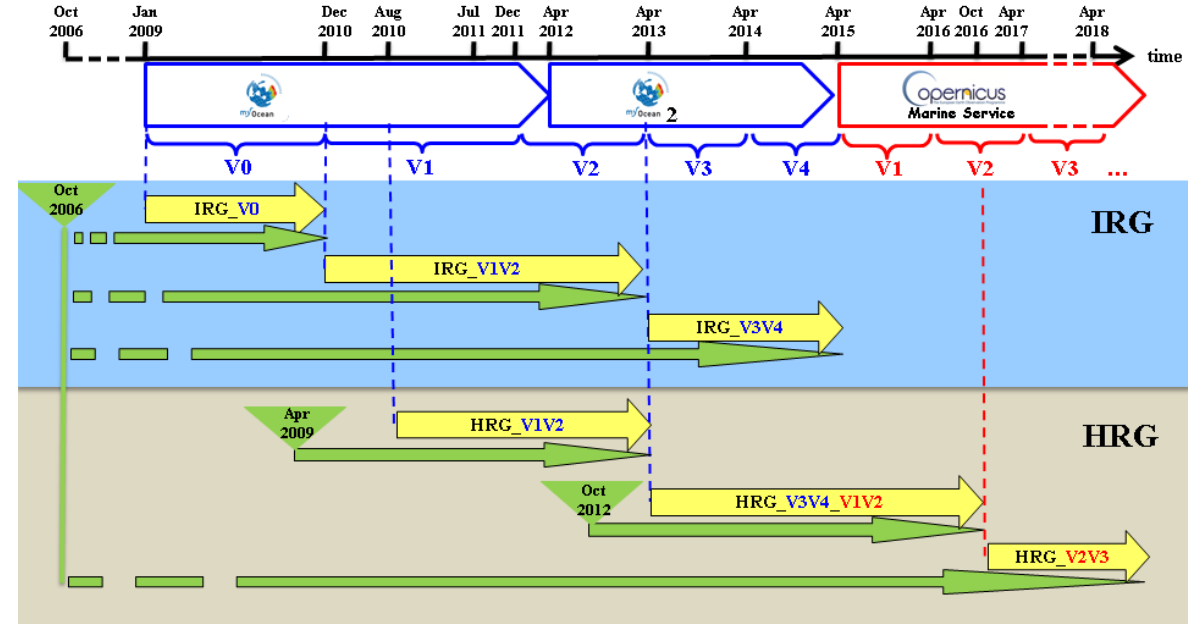
Figure 1. Timeline of the Mercator Ocean global analysis and forecasting systems for the various milestones (from V0 to V4) of the past MyOcean project and for milestones V1, V2 and V3 of the current CMEMS. Real-time productions are in yellow with the reference of the Mercator Ocean system. Available Mercator Ocean simulations are in green, including the catchup to real time. Global intermediate- resolution (high-resolution) systems at 1 / 4 ◦ (1 / 12 ◦ ) are referred to as IRG (HRG). Milestones are written in blue for the MyOcean project and in red for